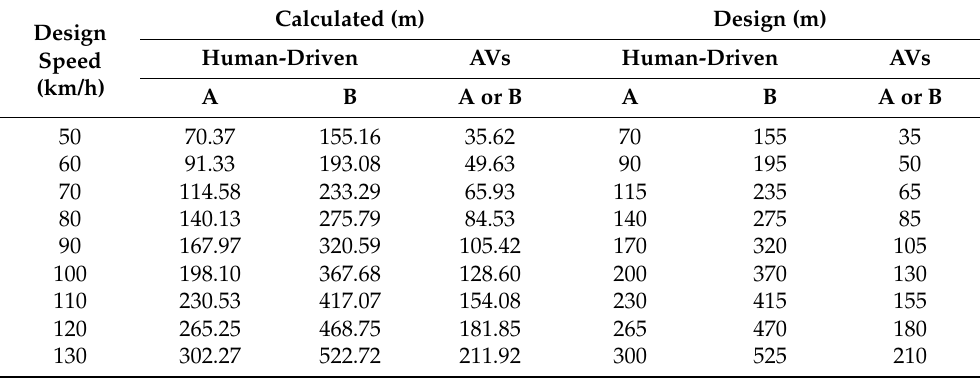
Table 2. Decision sight distance for cases A and B for both human-driven vehicles and